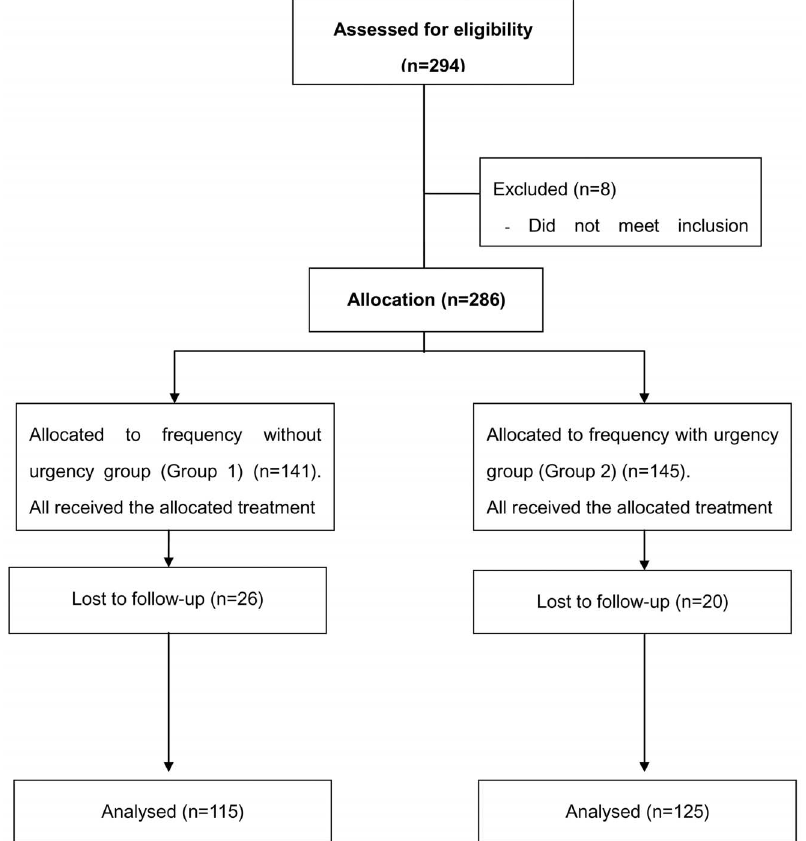
Figure 1. Participant flowchart.